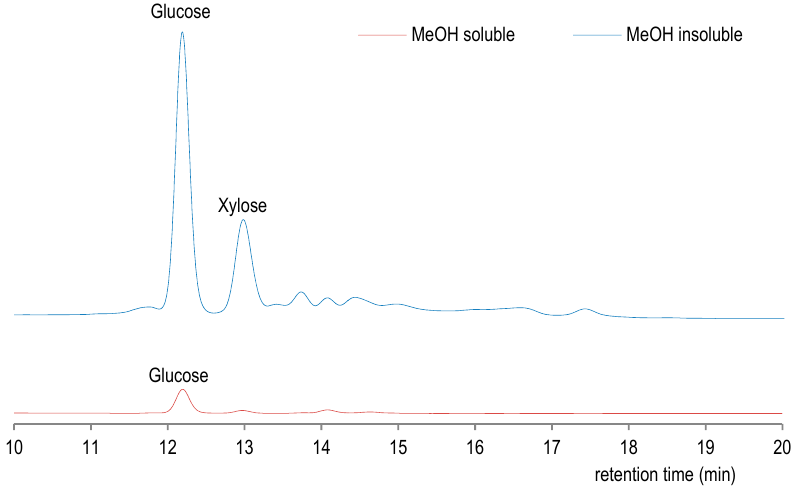
Figure 3. Comparative HPLC analysis for sugar content in methanol and water soluble fraction.